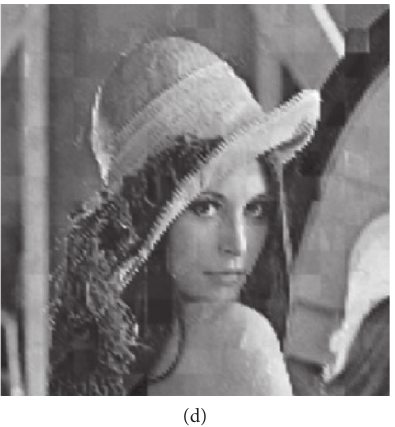
Figure 6: (a) The original image. (b) The random phase mask matrix. (c) The spares matrix. (d) The reconstructed image.